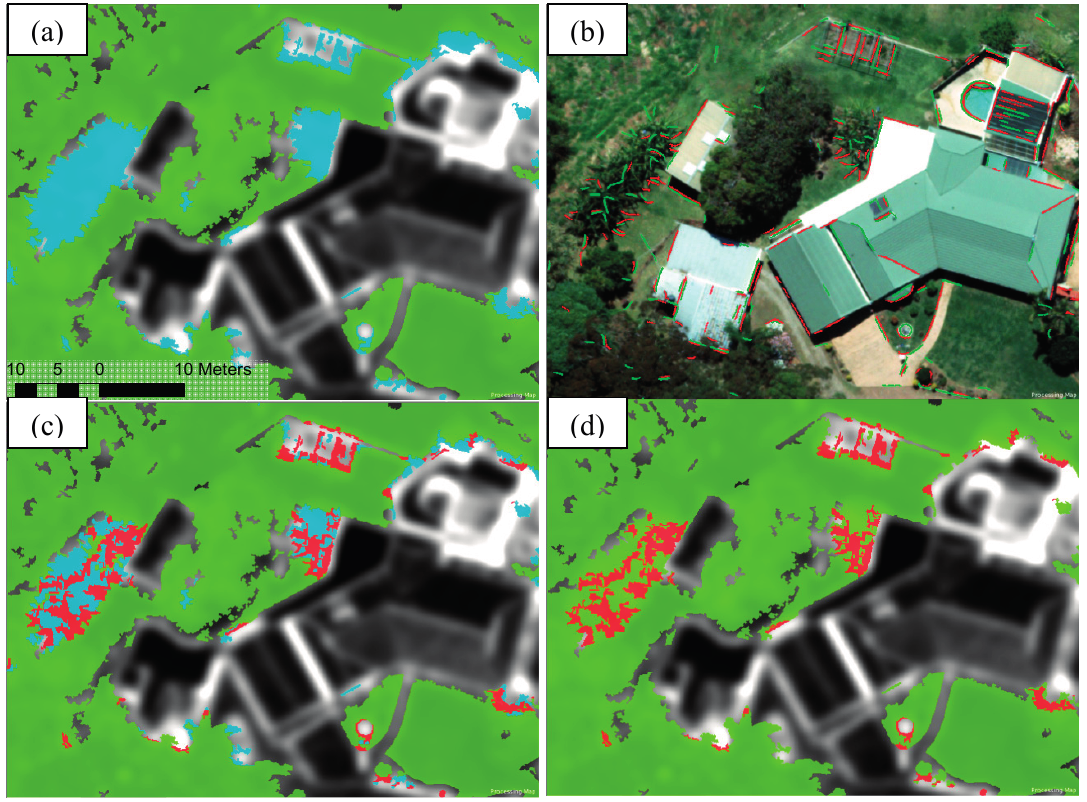
Figure 7. Classification of ( a ) banana plant candidates; ( b ) potential banana plant leaf (green lines) and banana plant leaf shadow (red lines) candidates; ( c ) coinciding banana plant candidates and banana plant leaf and banana plant leaf shadow candidates (red); and